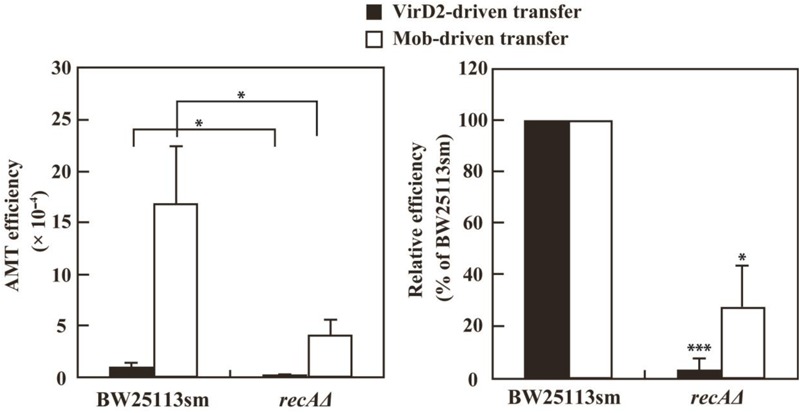
AMT efficiency of a recAΔ mutant derivative of the E. coli BW25113 strain. BW25113sm (recA+) and its recAΔ mutant strain were subjected to AMT. (Left) AMT efficiency. Single asterisks indicate significant difference (P < 0.05) by either Welch’s t-test (for pSRK-R316 as the transferred substrate) or Student’s t-test (for pAY205 as the transferred substrate). (Right) Relative efficiency calculated using the AMT efficiency of BW25113sm as a benchmark. Single and triple asterisks indicate that the averages of the relative efficiencies were not 100% (P < 0.05, P < 0.001, respectively) by one-sample t-test.